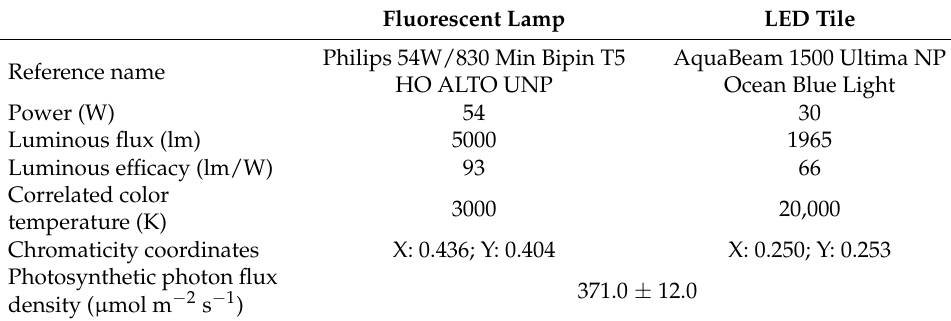
Table 1. Technical information of lighting